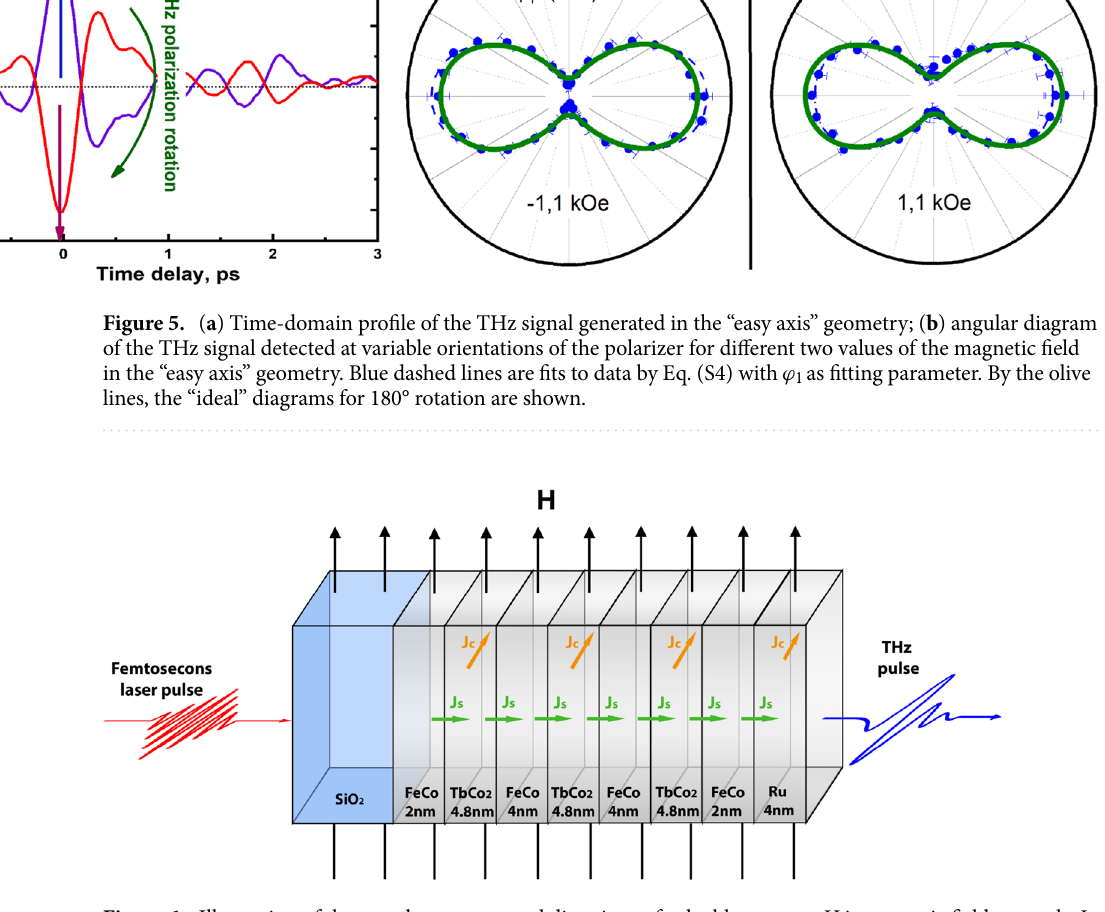
Figure 6. Illustration of the sample structure and directions of valuable vectors. H is magnetic field strength, J S is the spin-current, J C is the charge current.